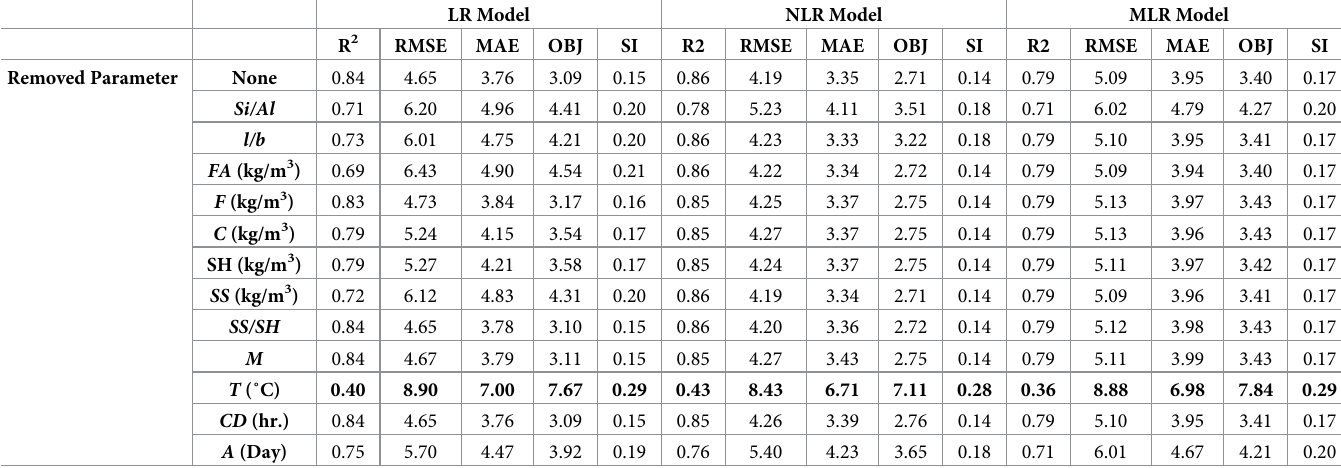
Table 2. Sensitivity analysis using LRA, NLRA, and MLRA